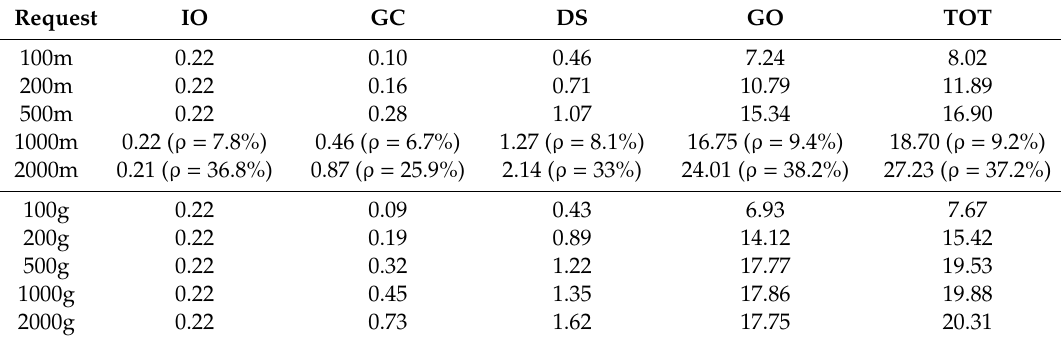
Table 10. Requests per second (total and for di ff erent SOS request) with di ff erent concurrent data consumers and WSGI applications for the test case of a medium size monitoring network (case B). Rate of failure ( ρ ) is reported when errors have been detected.